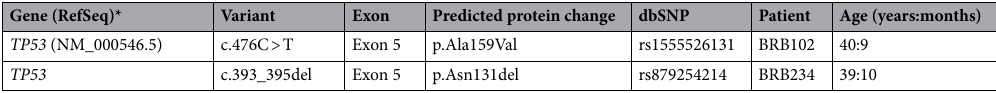
Table 2. Variants of unknown clinical significance identified in established and candidate breast or ovarian cancer genes in a South African Breast cancer cohort of African ancestry. Variants are named according to the Human Genome Variation Society (HGVS) nomenclature, where complimentary DNA (cDNA) numbering + 1 corresponds to the A of the ATG translation initiation codon. *Reference sequences obtained from the NCBI database. For BRCA1 the most common human transcript (NM_007294.3) is used with custom numbering of the exons (missing exon 4). # Not reported in dbSNP (http:// www. ncbi. nlm. nih. gov/ SNP), EVS (http:// evs. gs.